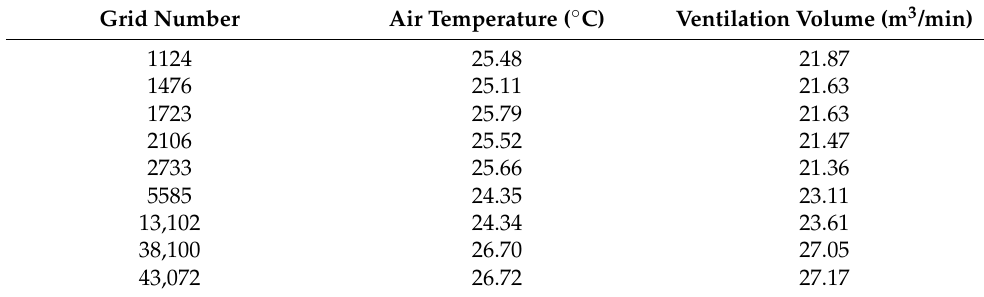
Table 4. Grid Independence